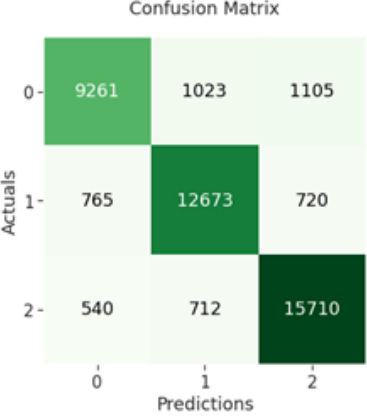
Figure 4. CNN confusion matrix.